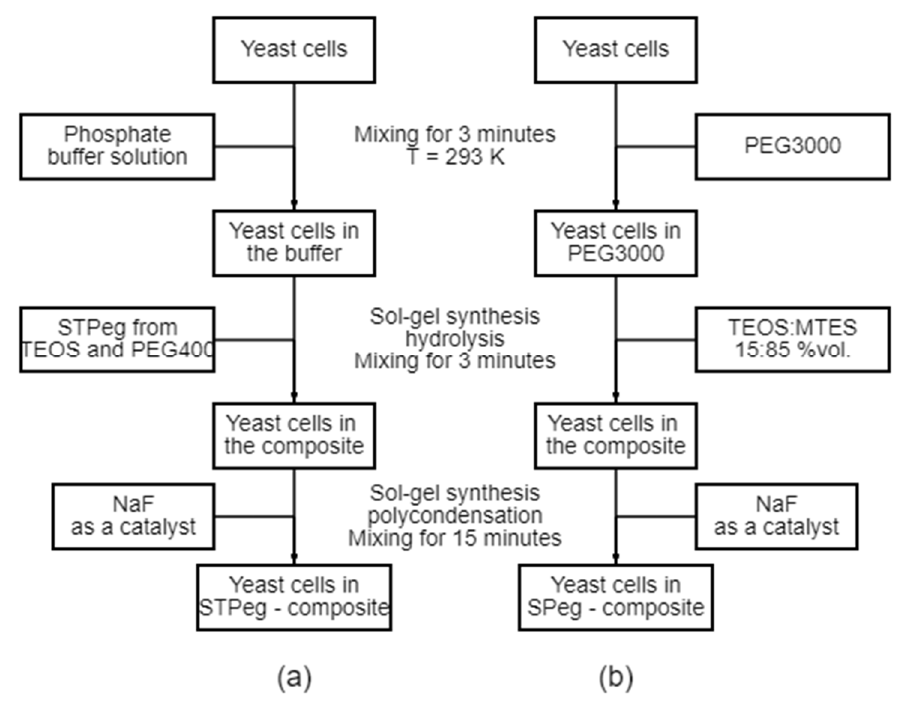
Figure 1. Immobilization of yeast cells in silica-polyethylene glycol-based composites by sol-gel synthesis: ( a ) immobilization of yeast cells in STP EG -composite; ( b ) immobilization of yeast cells in SP EG -composite.